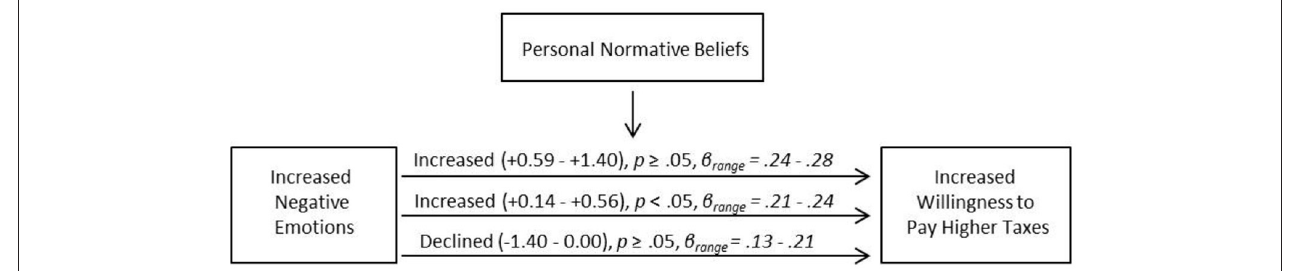
FIGURE 1 | Mediational model for positive relationships between increased negative emotions and increased willingness to pay higher taxes at given levels of change in personal normative